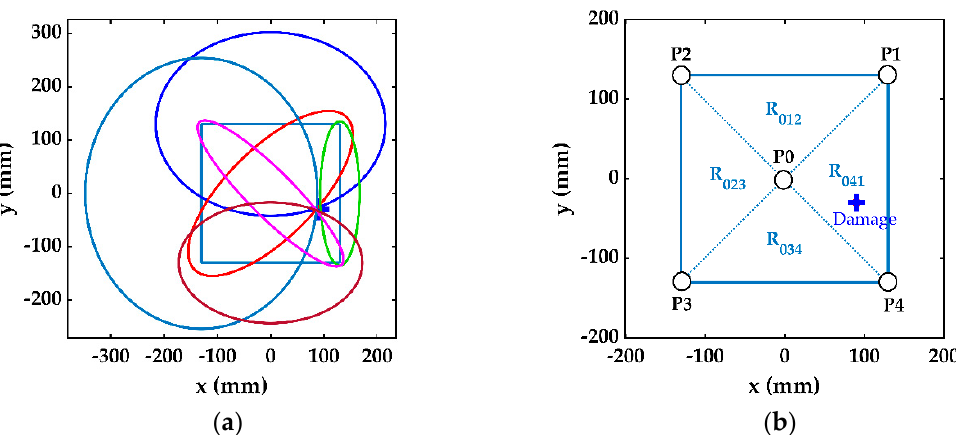
Figure 11. ( a ) Six additional ellipses in multistage detection. ( b ) Identification of damaged subcell.